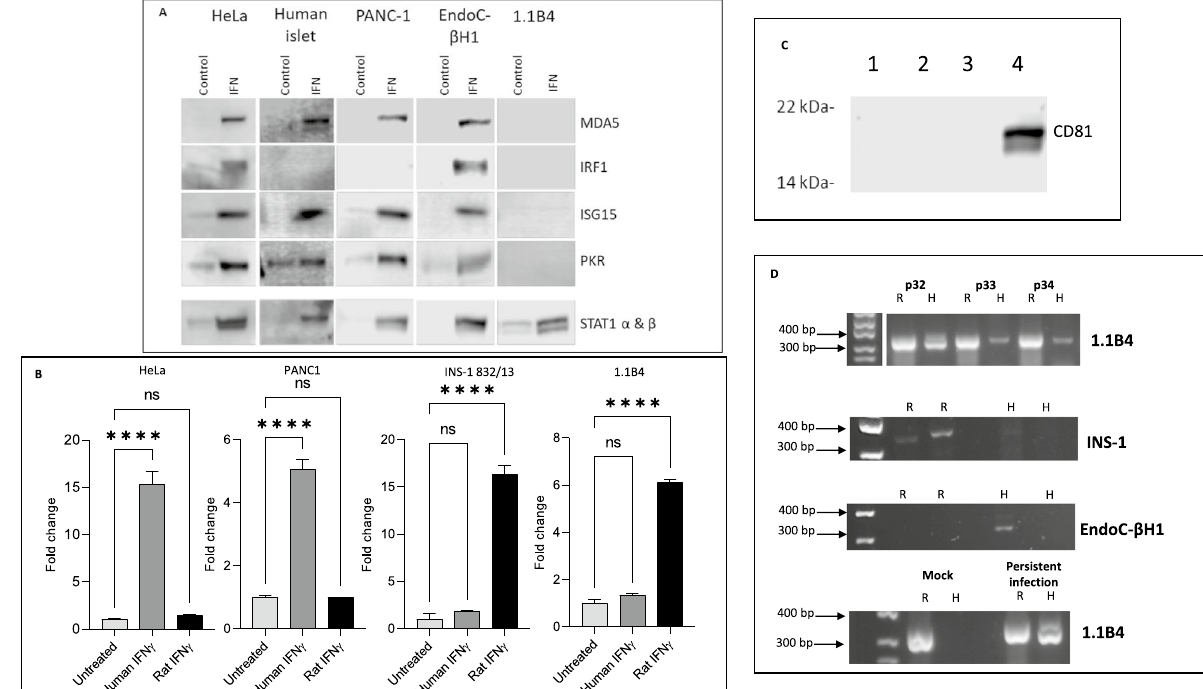
Figure 3. Species specificity of anti-viral responses measured in 1.1B4 cells by comparison with those seen in a range of additional cell types. ( A ) The induction of a selection of viral response proteins was studied in 1.1B4 cells following exposure to human interferon-alpha (IFN; 1000U/ml) for 24 h. The profile was compared with that seen in EndoC-βH1, PANC-1 and HeLa cells as well as in isolated human islets, incubated under the same conditions. Controls received vehicle alone. Images of full blots are available in supplementary information. ( B ) 1.1B4, PANC-1, HeLa or INS-1 832/13 cells were each transfected with a luciferase reporter construct under the control of a GAS promoter and then incubated with either 20 ng/ml human IFNγ or rodent IFNγ for 24 h. Reporter activity was measured in cell extracts and expressed relative to that measured in untreated cells. **** = P < 0.0001; ns = not significant. ( C ) Exosomes were harvested from the culture medium of 1.1B4 cells (lanes 1–3) or from PANC-1 cells (lane 4) and protein extracts probed for the presence of the marker protein CD81 using a human-specific antiserum. Immunoreactive proteins were detected by Western blotting. ( D ) DNA was harvested from 1.1B4 cells at increasing passage, as shown (upper panel) and amplified using primers targeting vomeronasal receptor sequences of either rat (R) or human (H) origin. INS-1 832/13 (second panel) and EndoC-βH1 cells (third panel) were used as rat or human positive controls, respectively. Either mock or CVB4.E2-infected 1.1B4 cells were also harvested and analysed at 71 days post infection (lower panel). Images of the whole gel are available in supplementary